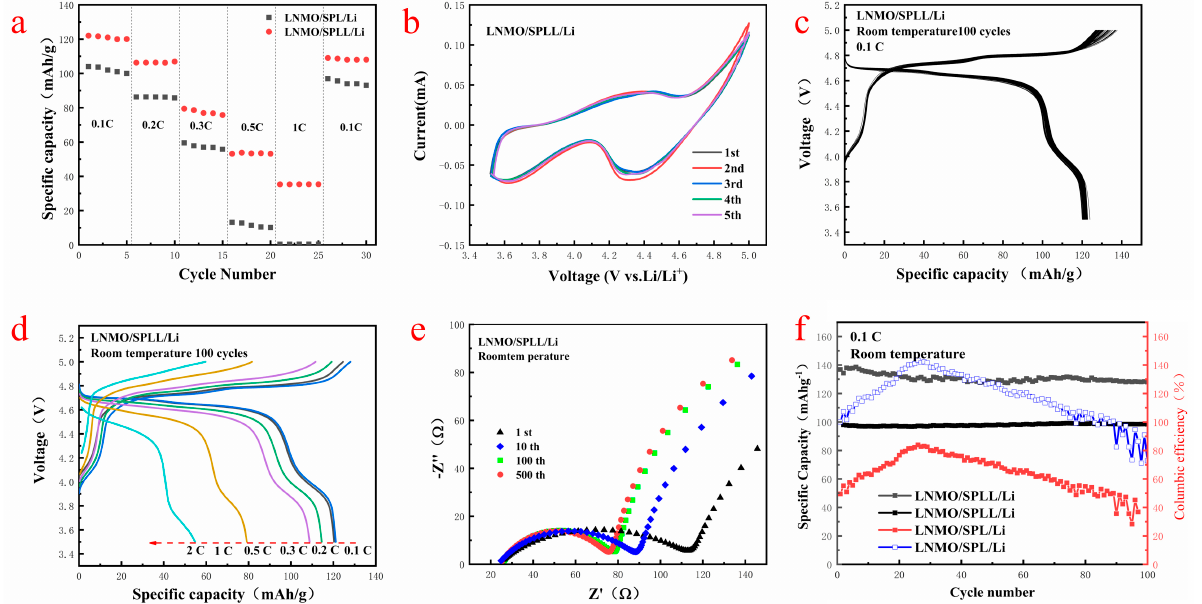
Figure 7. Electrochemical performance of the all-solid-state cell with LNMO cathode and SPLL: ( a ) rate capability; ( b ) CV curves of LNMO/SPLL/Li; ( c ) typical discharge − charge profiles at 0.1 C rate; ( d ) charge/discharge curves under various current densities ranging from 0.1 to 2.0 C; ( e ) Nyquist plots; and ( f ) the cycling performance between 3.5 and 5 V at 0.1 C rate.